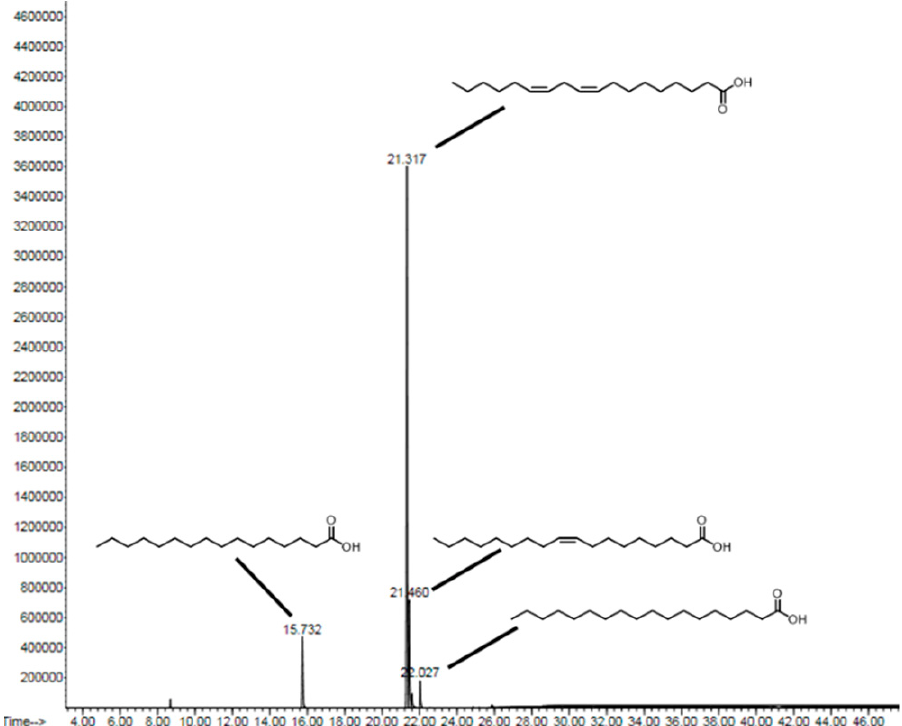
Figure 3. GC/MS analysis of acyl chains in starting PC with the indication of the chemical formula of each acid (Retention time reported in